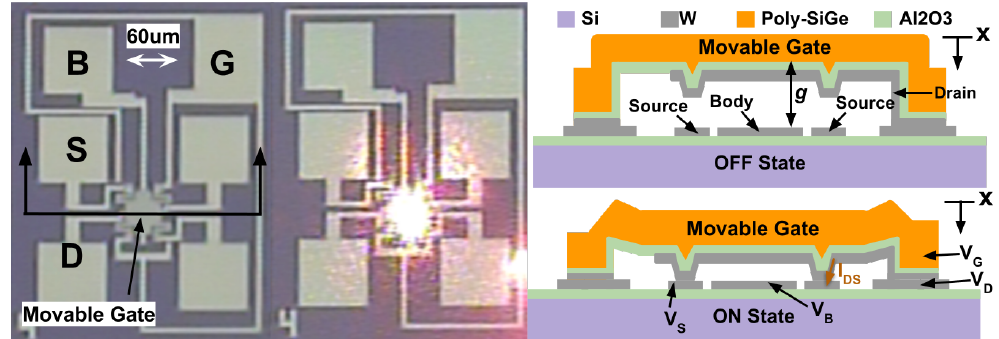
Figure 1. ( left ) A microscope image of the microelectromechanical (MEM) relay device. Body (B), gate (G), source (S), and drain (D) terminals are labeled. (center) A microscope image of the relay showing the laser spot used for laser Doppler vibrometry (LDV). ( right ) A cross-section of the device that indicates the terminals and the signals applied during operation: V g , V d , V s and V b . The cross-section shows that when a voltage difference is applied between the Gate and Body, the device is closed and current ( I ds ) can flow. The actuation gap, g , is also